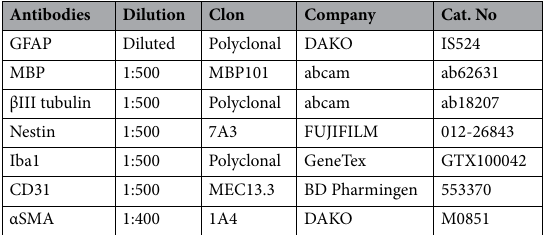
Table 1. The information of